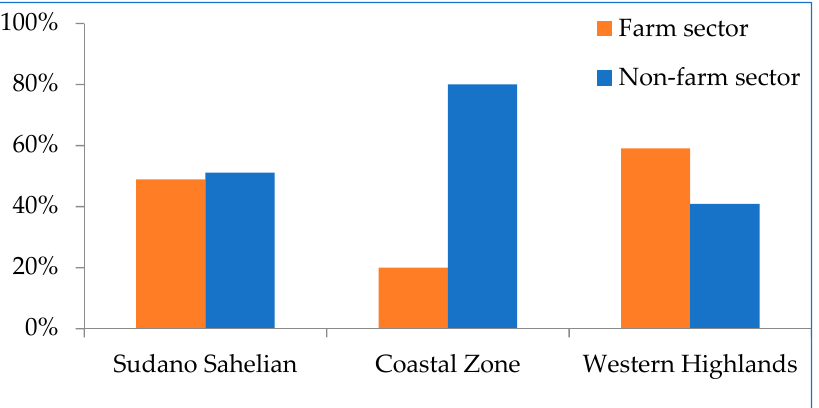
Figure 3. Main sector of employment of household head, per geo-ecological zone. Analyses of additional socio-demographic variables are presented in Table 1. The mean age of the respondents was significantly higher in the Coastal zone (Zone II), compared to the Western Highlands (Zone III) and the Sudano-Sahelian zone (Zone I): 45 years, 38 years, and 33 years, respectively. The mean age for the entire sample (39 years) is not very different from the mean of 41 years reported in a recent study on Cameroon [8]. Differences were further observed in mean household sizes, with Zone III recording the largest household size, followed by Zone I and then Zone II (8, 7, and 6 household members, respectively). The mean monthly household income in Zone III was significantly higher compared to Zone I and Zone II (FCFA183,710 [US$ 288], compared to FCFA55,780 [US$ 87.5], and FCFA89,300 [US$ 140.1], respectively). It is, therefore, expected that, given the older age of the household heads and the higher household incomes, the flood victims in the Western Highlands (Zone III) will better cope with floods, compared to those in the other geo-ecological